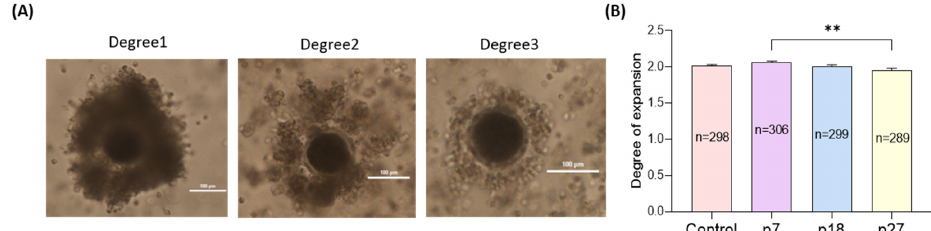
Figure 1. Effects of different passages of eAFMSC-CM on cumulus expansion. ( A ) The degree of cumulus cell expansion was classified into three grades: Degree 1 (no cumulus expansion), Degree 2 (moderate expansion), and Degree 3 (full expansion). ( B ) Average the degree of cumulus cell expansion. p7; eAFMSC-CMp7, p18; eAFMSC-CMp18, p27; eAFMSC-CMp27. The asterisks represent significantly different when compared to the control (**: p < 0.01). Scale bar = 100 μ m. Figure 2 shows the relative expression of genes associated with apoptosis, antioxi- dant enzymes, cumulus cell expansion, and gap junctions in porcine cumulus cells ana- lyzed using qPCR. The BAX/BCL-2 ratio was significantly lower in the eAFMSC-CMp7 group than in the control ( p < 0.05). The expression of antioxidant-related genes, SOD2 and NRF-2, was significantly increased in the eAFMSC-CMp7 group compared to the con- trol and other eAFMSC-CM groups ( p < 0.05). Furthermore, the expression of genes asso- ciated with cumulus expansion, namely tumor necrosis alpha induced protein 6 (TNFAIP6) and prostaglandin-endoperoxide synthase 2 (PTGS2), was significantly in- creased in the eAFMSC-CMp7, compared to all other groups ( p < 0.05). Levels of Cx43 transcripts were also significantly increased in eAFMSC-CMp7 compared to the other groups ( p < 0.05).